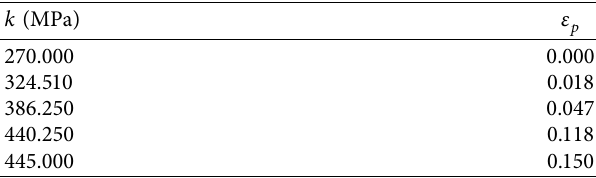
Table 2: k − ε p experimental data for Q235 steel.